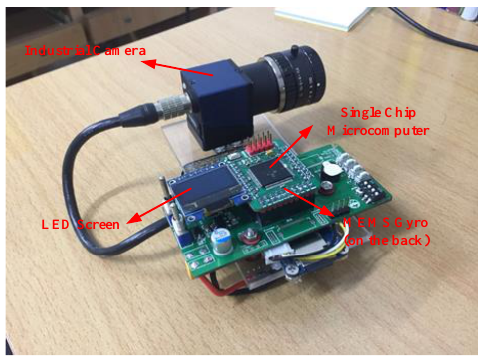
Figure 20. The integrated system. Table 3. The parameters of integrated